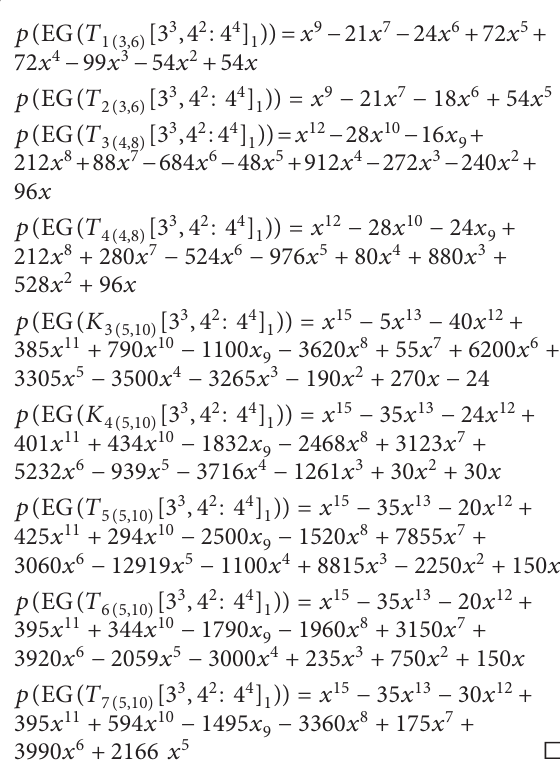
. 1 ≇ K - [ 3 3 , 4 2 : 4 4 ] 1 4 ( 5 , 10 )